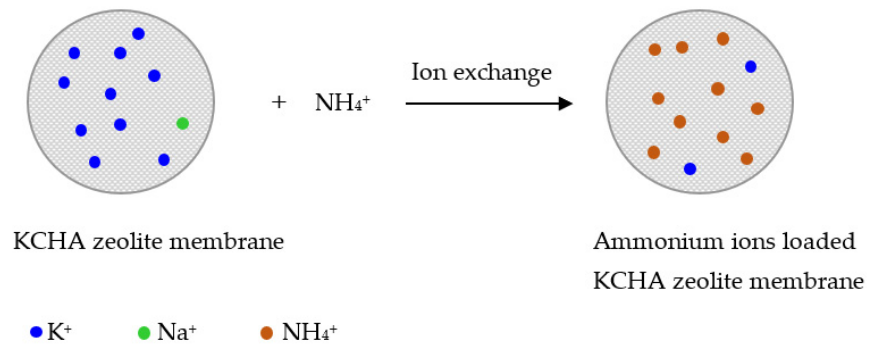
Figure 1. Diagram for modification of KCHA zeolite membrane.